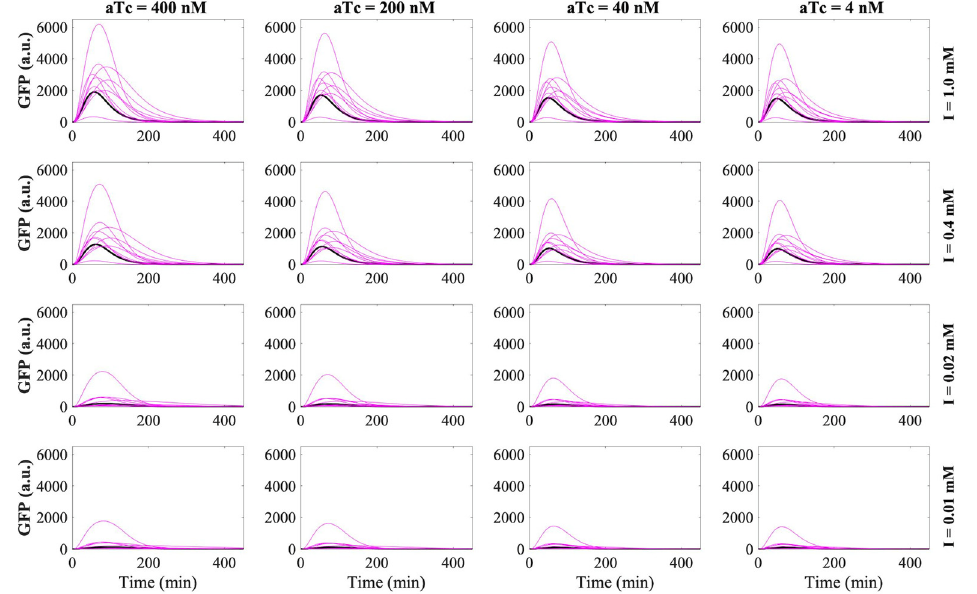
Figure 5. RNA–protein hybrid IFFL circuit simulation and kinetic parameter sensitivity analysis. The solid black line represents the model prediction at the nominal kinetic parameter estimates. The solid magenta line represents the ten random kinetic perturbations for each subplot. The letter ‘I’ represents IPTG.